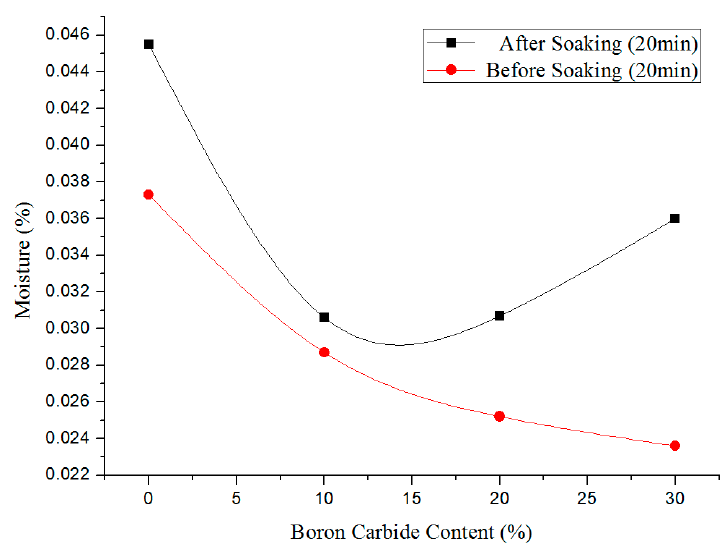
Figure 6. Change in water content of boron carbide PEEK composite before and after soaking in water.